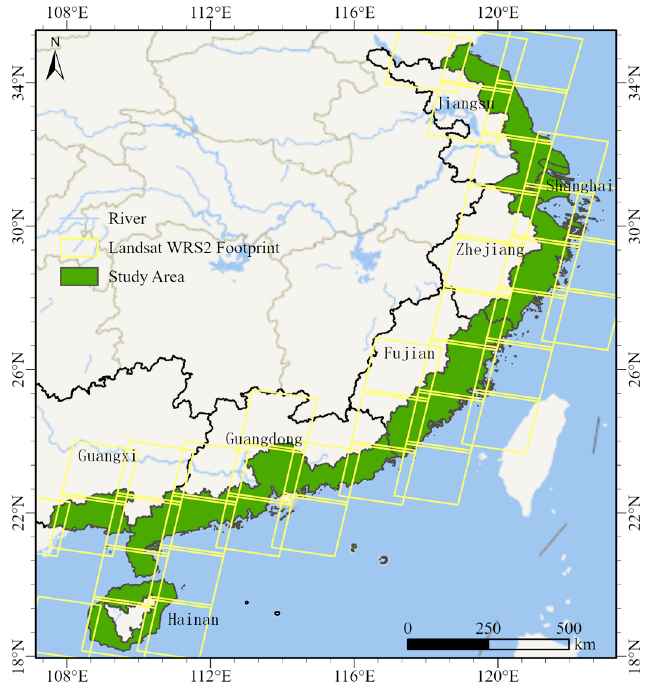
Figure 1. Study area.